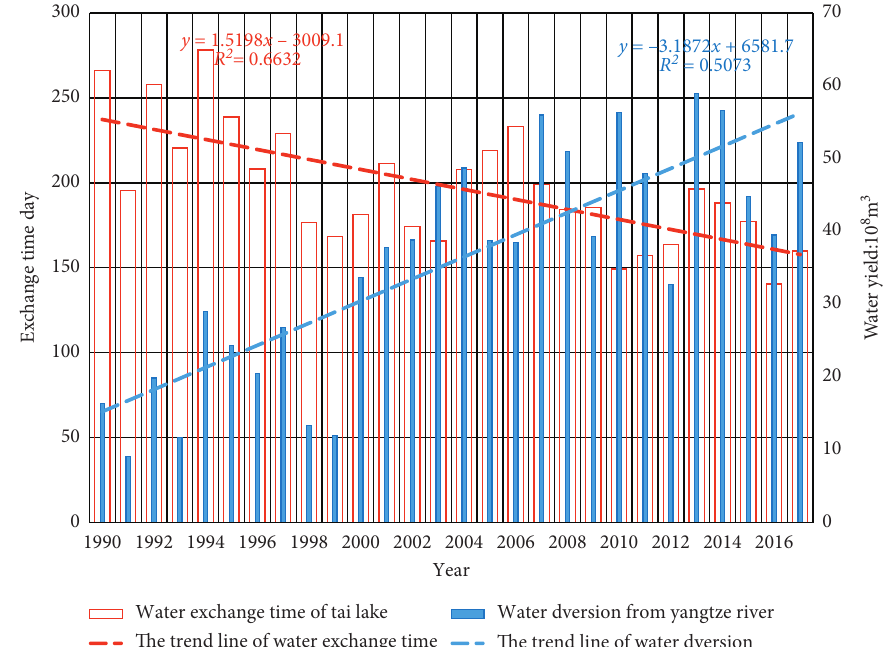
Figure 2: Trends in the amount of water entering Tai Lake from 1990 to 2017 and its water body exchange